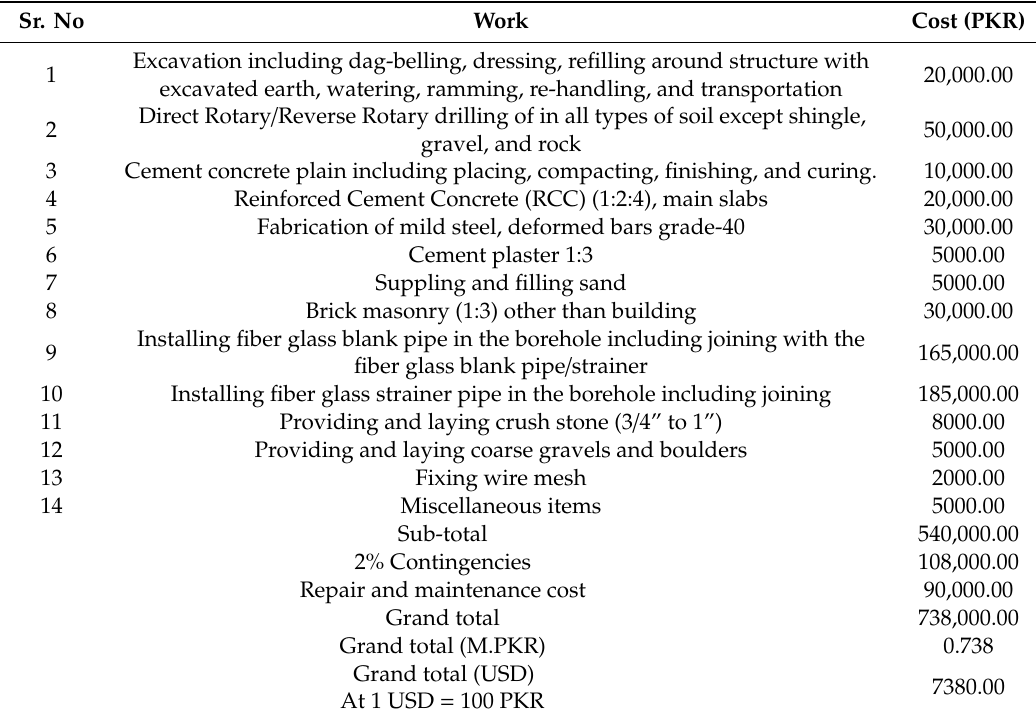
Table 5. Cost of civil work and elements include in RWH